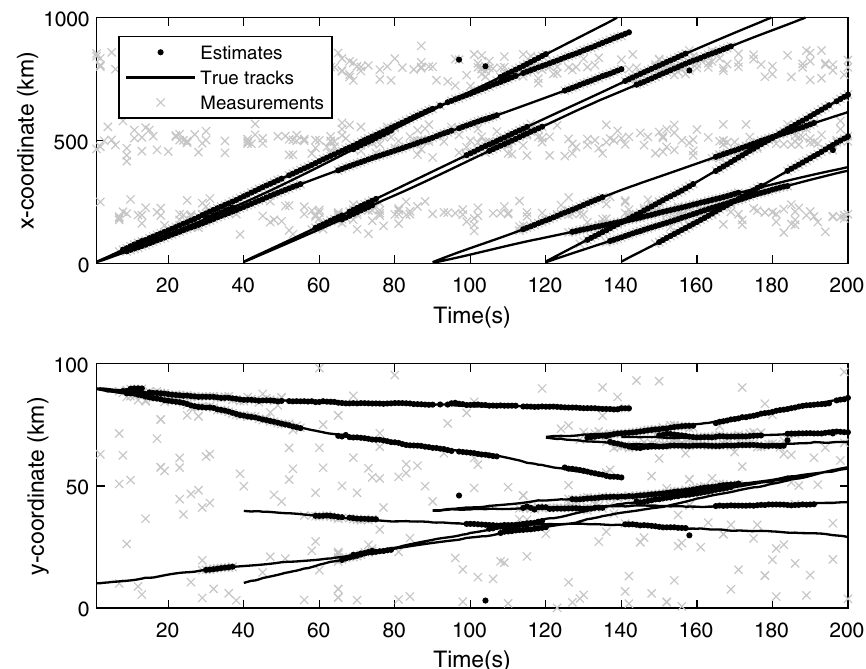
Fig. 9 The true tracks vs. estimated tracks in x , y directions(10 targets)